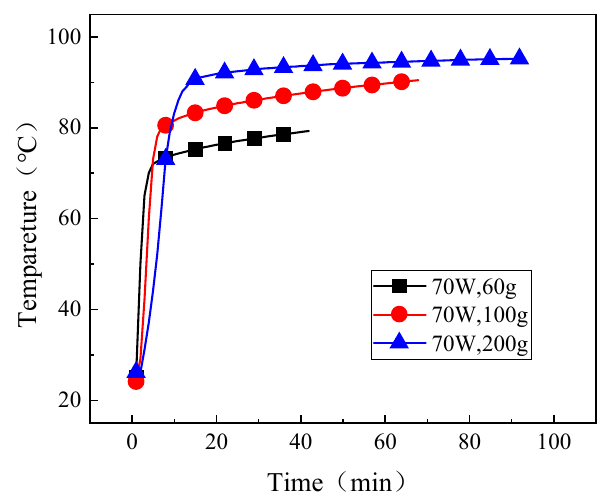
Figure 6. Microwave drying rate of corn with different loads.